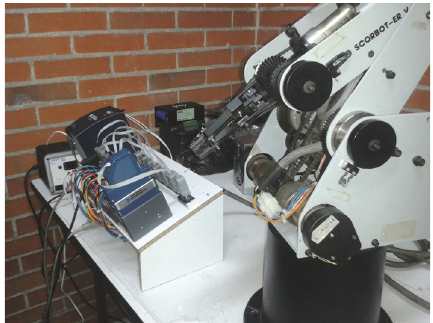
Figure 1: Robot manipulator Scorbot ER 4PC.